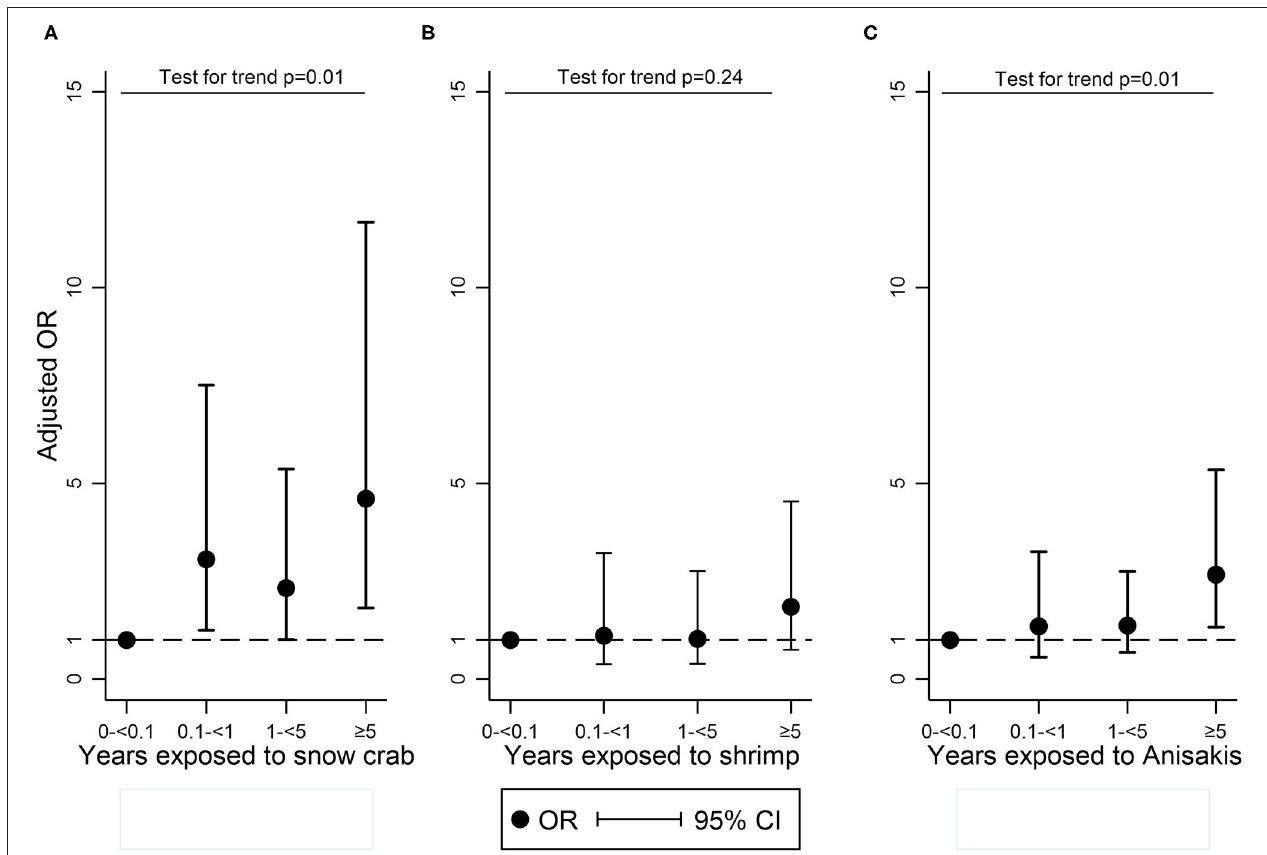
FIGURE 1 | Logistic regression* with trend test exploring a dose-response relationship between sensitization to snow-crab (A) , shrimp (B) , and A. simplex (C) and the total time exposed to snow-crab, shrimp, and fish when working in the seafood processing industry in four exposure groups (0– < 0.1 year, 0.1– < 1 year, 1– < 5 years, ≥ 5 years). The dashed line shows OR =